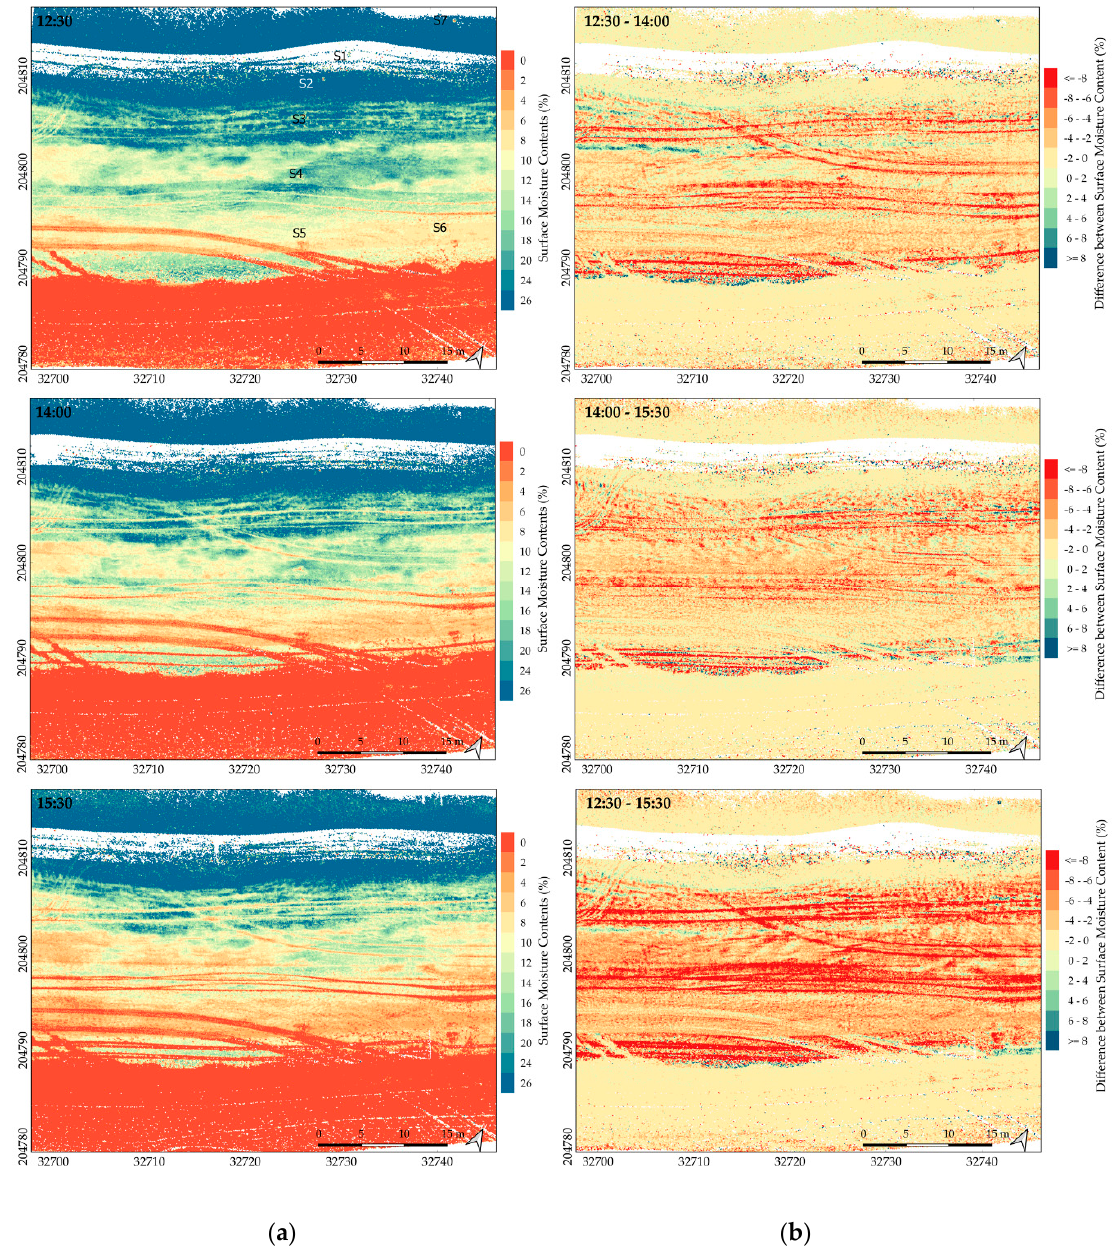
Figure 12. ( a ) The beach surface moisture at 12:30, 14:00 and 15:30, respectively and ( b ) the moisture differences between these three time moments. The moisture map of 12:30 also presents the position of the samples S1–S7. the samples